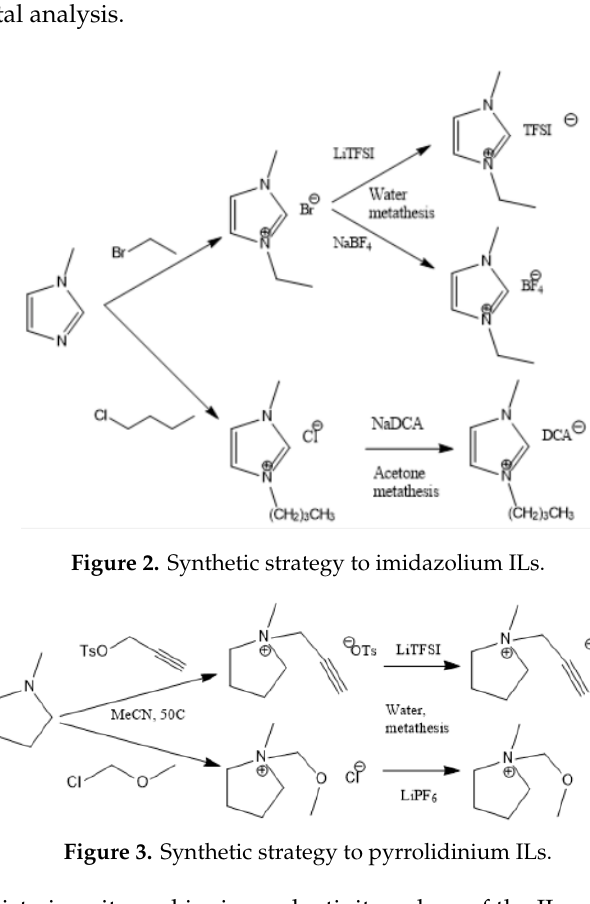
Figure 4. Improved synthetic strategy to prepare DCA-based ILs [33]. Tables 1–3 list viscosity and ionic conductivity values of the ILs synthesized. Surprisingly, ether group-containing ILs displayed better ionic conductivity when compared with the corresponding alkyl analog (e.g., Py 11O1 TFSI vs. Py 13 TFSI). DCA anion-based ILs are the best when it comes to both low viscosity and high ionic conductivity. Among the hydrocarbon substituted ILs, allyl group containing ILs displayed superior properties than alkyl or alkyne group containing ILs (e.g., Py 1A TFSI vs. Py 1P TFSI and Py 13 TFSI). In general, sulfonium-based ILs display low viscosity, but it did not translate to high ionic conductivity for most compounds except for S 221O2 DCA (new ether group-containing compound), which displayed remarkably low viscosity (25.3 cP) and high ionic conductivity (11.6 mS cm − 1 ). We have also identified two ILs with outstanding properties, Im 12 DCA (viscosity, 14.8 cP and ionic conductivity, 26.3 mS cm − 1 ) and S 222 DCA (viscosity, 14.4 cP and ionic conductivity, 26.9 mS cm − 1 ). Although their Li-salt dissolution power is very poor, we believe that they can be used as a thinner solvent to improve the properties of our new ether group-containing ILs ( vide infra ).